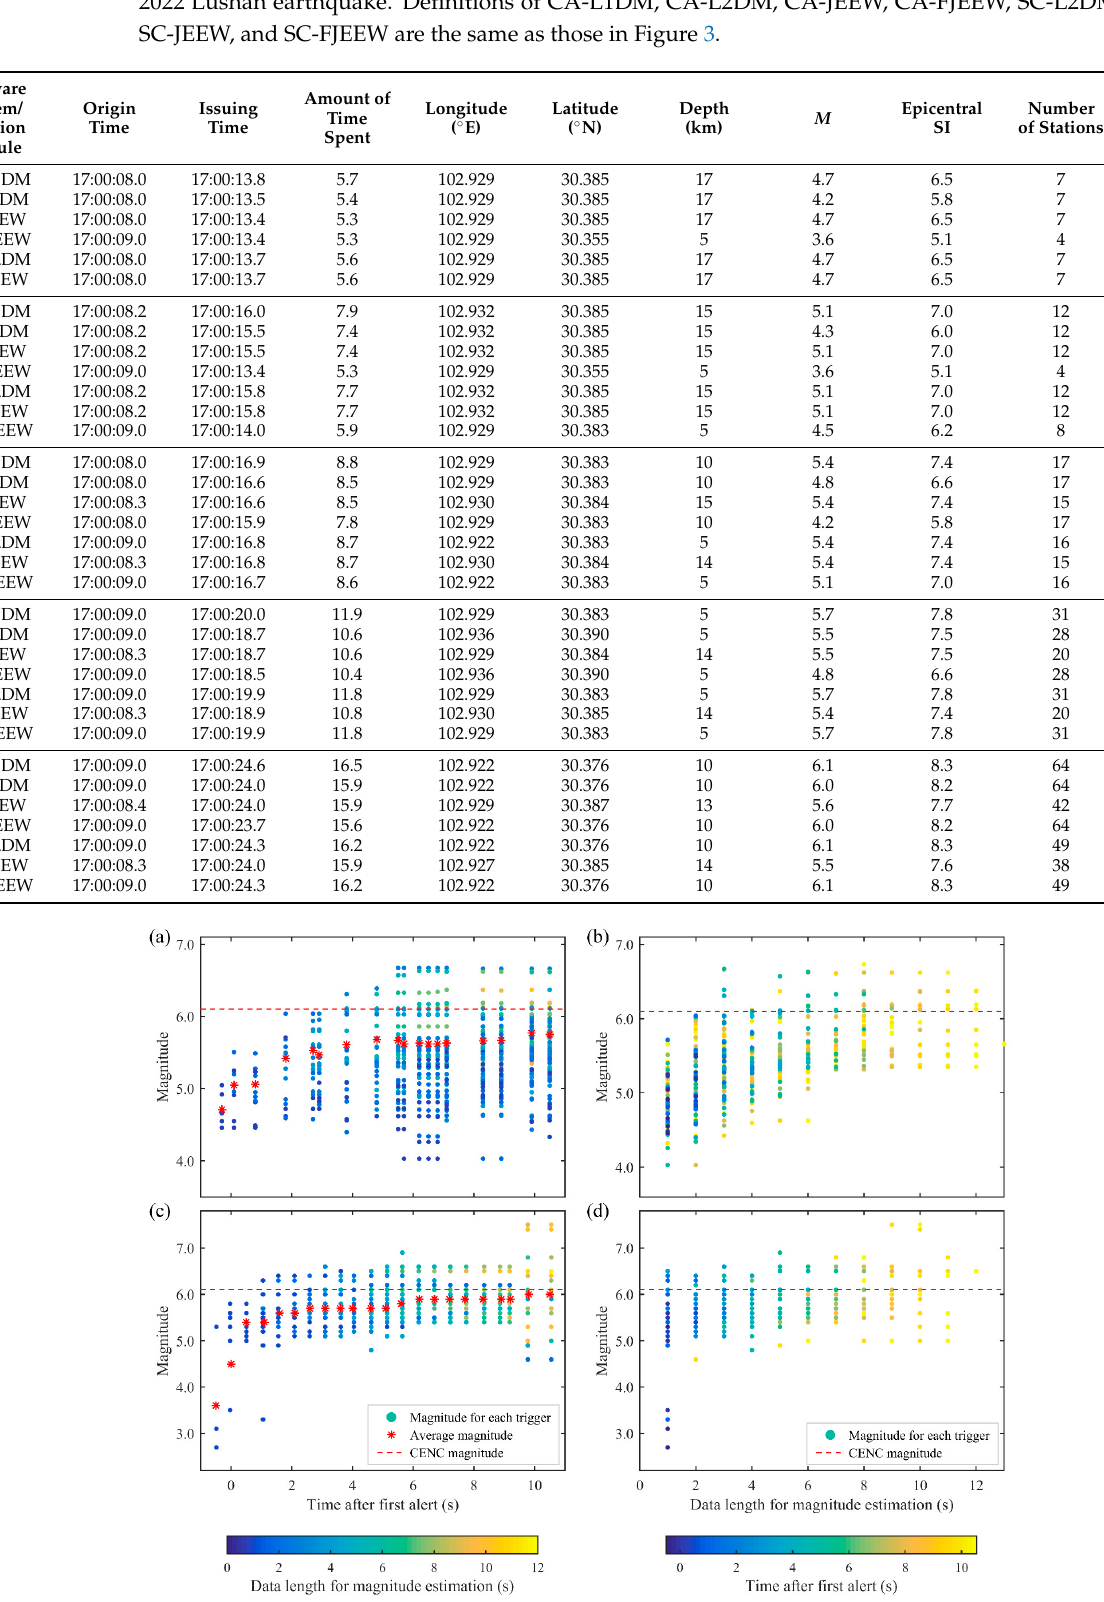
Figure 4. Examples of single station magnitude estimates (circles) and average magnitude estimate (asterisks) at each update for the 1 June 2022 M 6.1 Lushan earthquake. The single station estimated magnitude clearly depends on the data length used to generate the estimate. By averaging all single station estimates available at each update, the overall estimated magnitude is clearly underesti- mated because of the lower magnitude estimates calculated from the short P -wave time window. The SC-JEEW generated results are plotted in ( a ) and ( b ), while ( c ) and ( d ) show data obtained from the SC-FJEEW. Left , magnitude estimate as a function of time after first alert (s) to present how the overall estimated magnitude evolved with time for this earthquake. Right , magnitude estimate as a function of data length used for magnitude estimation.